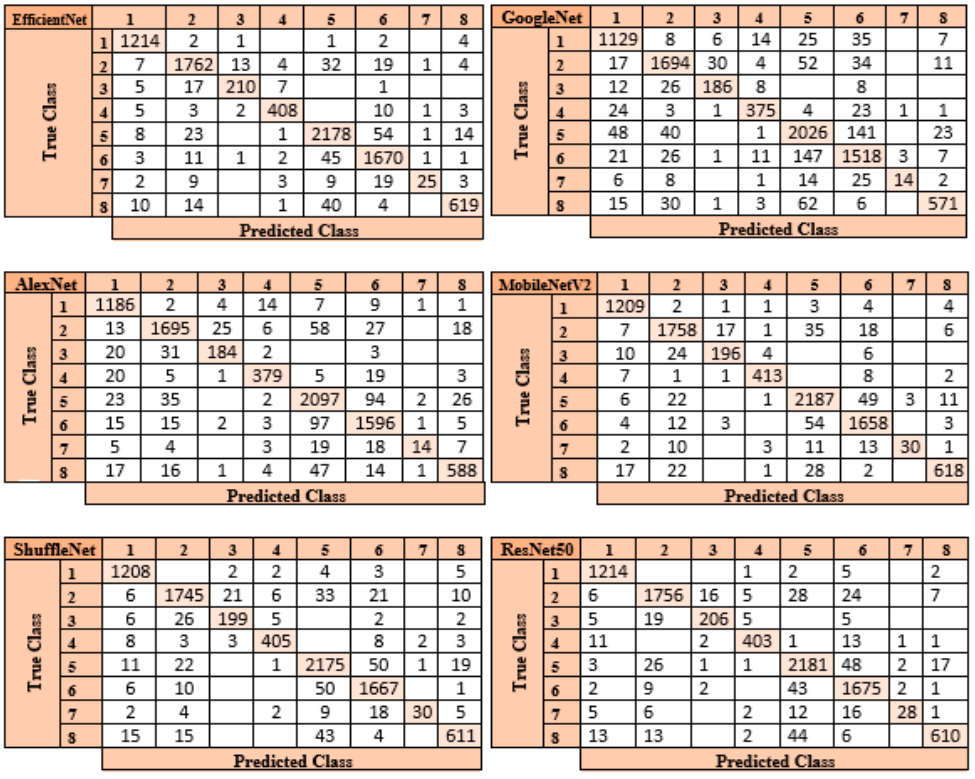
Figure 7. Confusion matrices of the Pre-trained Models+ SVM + Classifiers.